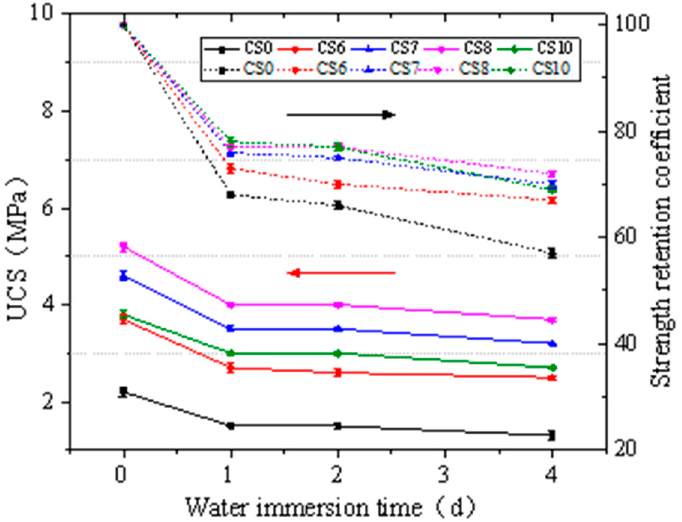
Figure 7. Influence of water immersion on UCS of stabilized clay of cement CFBS. The error bars represent the standard deviation of the test results for five samples.